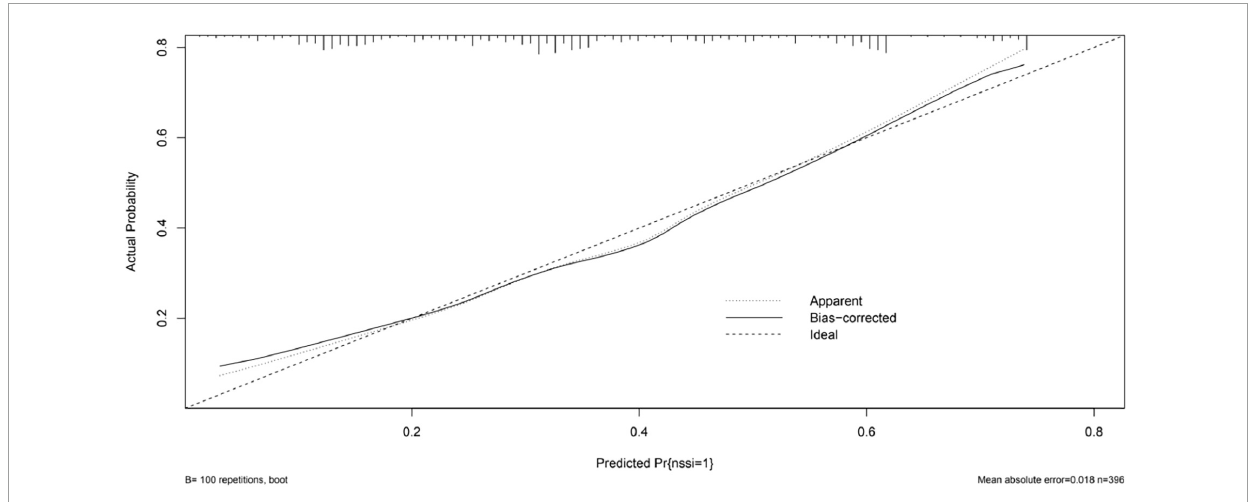
FIGURE3 The logistic calibration curve of the prediction nomograms of risk factors for NSSI in female patients with mood disorders.